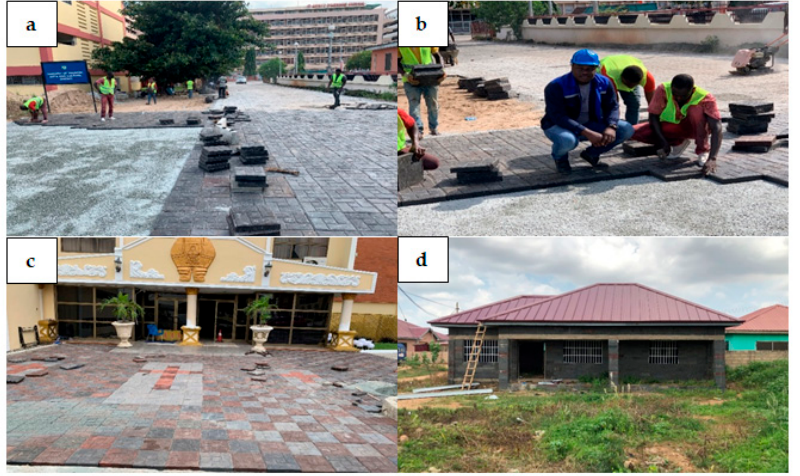
Figure 3. Shredded plastic waste mixed with sand to form pavement blocks. ( a ) Arranging plastic pavement blocks to lay, ( b ) plastic pavement blocks being laid, ( c ) completed laid plastic pavement block, ( d ) house constructed from plastics. Source: Nelplast Ghana Limited